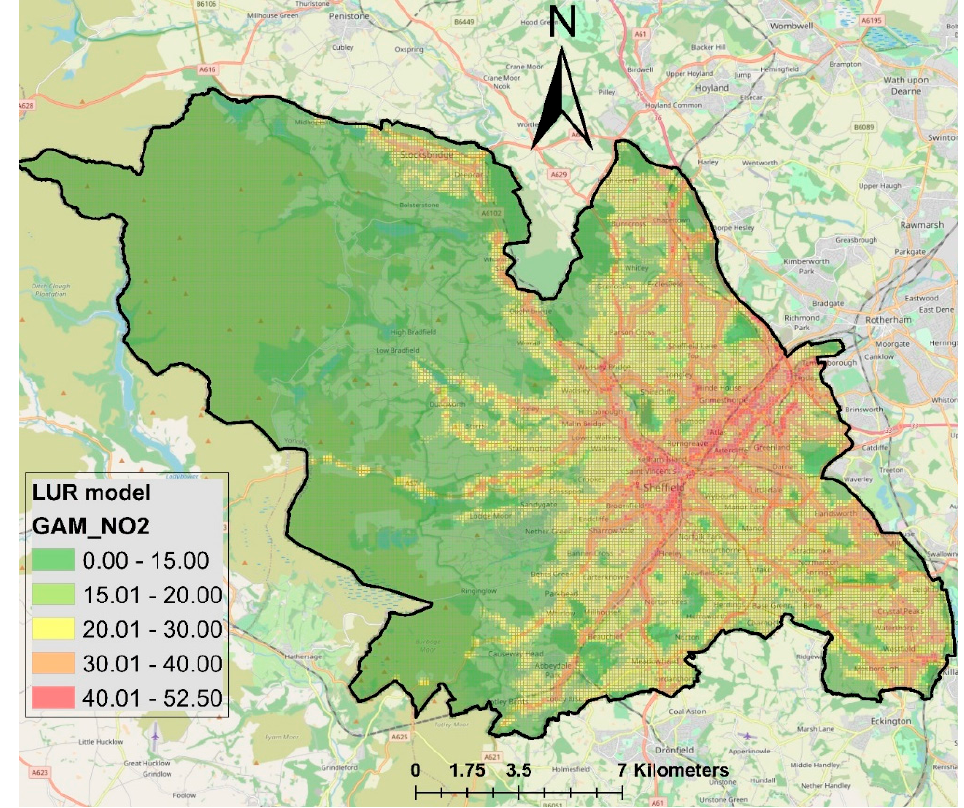
Figure 3. Maps of annual mean modelled NO 2 (µg/m 3 ) estimated by LUR model in Sheffield. Modified from [12].